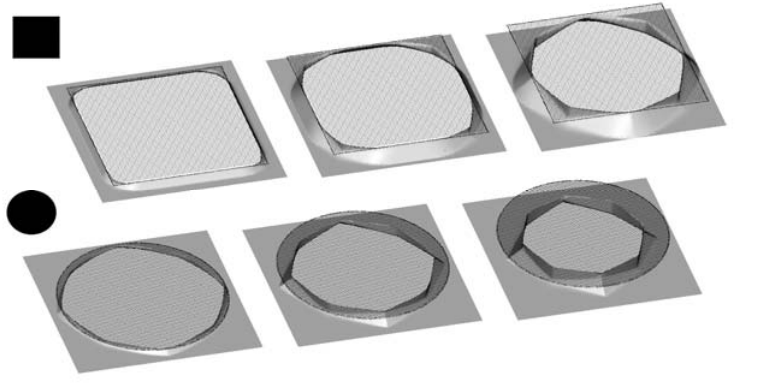
Figure 9. Convex corner undercutting. Initial aperture is aligned to <110> directions. Evolution of the profiles for the square (upper row) and the circular (lower row) masks, with the dotted masks superimposed, are presented.